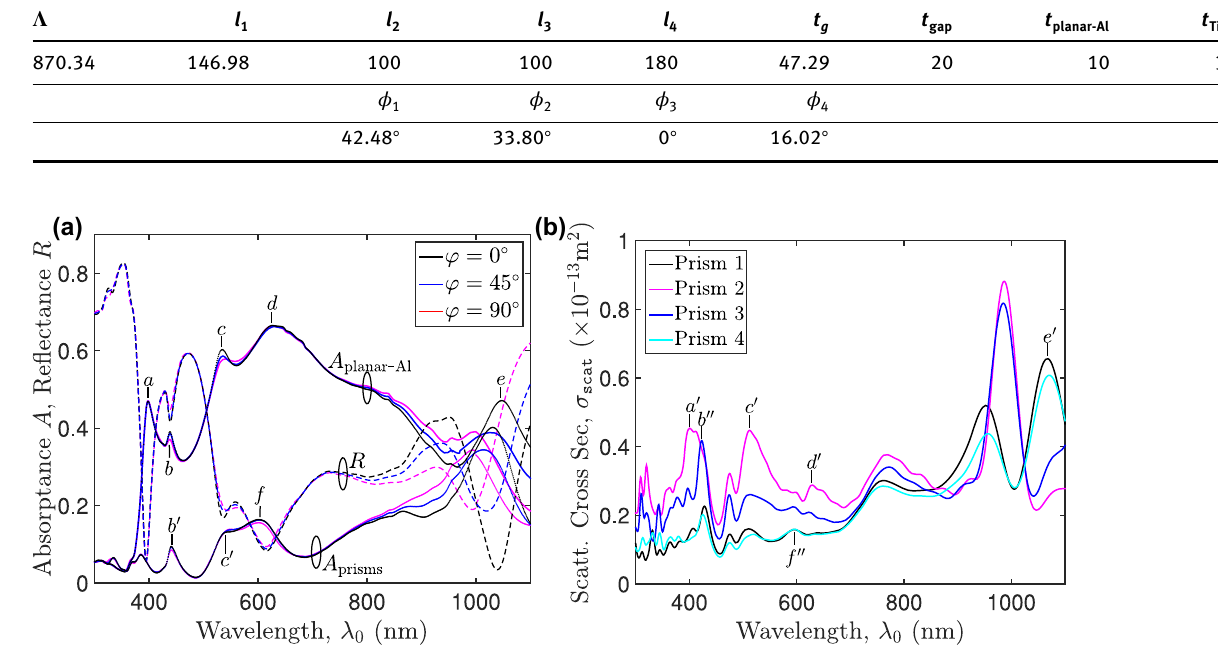
Figure 4: Spectral behaviors of the present Schottky PD [Figure 1(a)] at normal incidence of a plane wave: (a) absorptance A and reflectance R spectra at differing polarization angles of 𝜑 = { 0 ◦ , 45 ◦ , 90 ◦ } relative to the plane of incidence and (b) scattering cross section 𝜎 single nano-square prism positioned at the center of one unit cell computed at 𝜑 = 0 ◦ . Peak wavelengths in (b) close to those of A (a) are labeled using the primed/double primed letters in one-to-one correspondence.